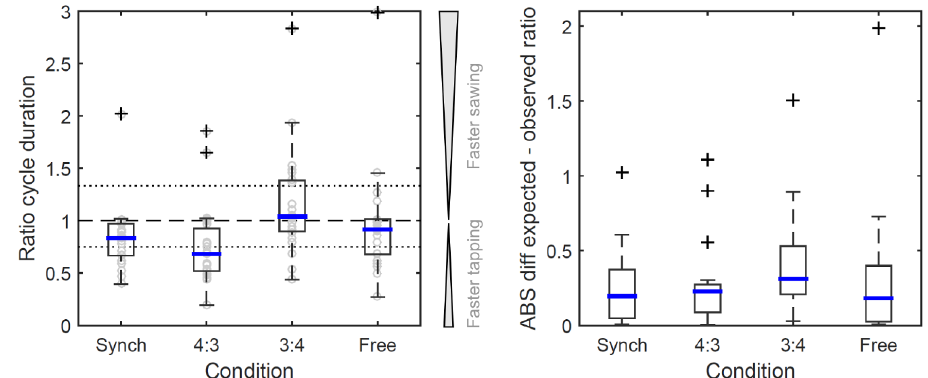
Fig 2. Left: boxplot for the ratios of tappingto sawingcycle durationcalculatedfor the four dual movement tasks. Right: Absolutedifference (‘ABS’) betweenexpectedand observedratio for each participant. Experimental conditions: ‘synch’–synchronised tappingand sawing(1:1), expectedsince the metronomebeat was set accordingto the preferredsawingcycle duration; ‘4:3’—4 beats tappingagainst 3 beats preferred sawingcycle durationper measure; ‘3:4’—3 beats tappingagainst4 beats preferredsawingcycle durationper measure. Dashedline: ratio 1:1 (identical cycle durationfor tappingand sawing); dotted lines: ratio 0.75 for condition‘4:3’ (tappingdurationis shorter than sawingduration)and 1.33 for condition‘3:4’ (tappingduration is longerthan sawingduration).Please note that conditionlabels are given as the equivalent of a frequency for ease of understandingthe experimental condition.